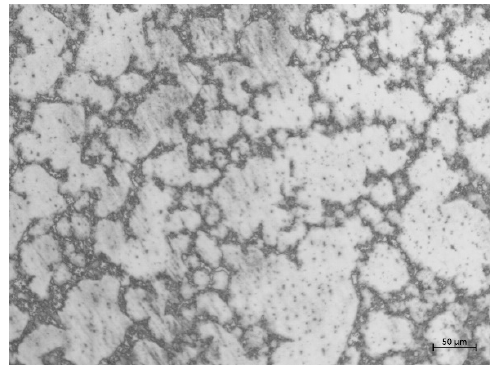
Figure 1. Image of AZ31B showing microstructure after treatment with 4% nital.